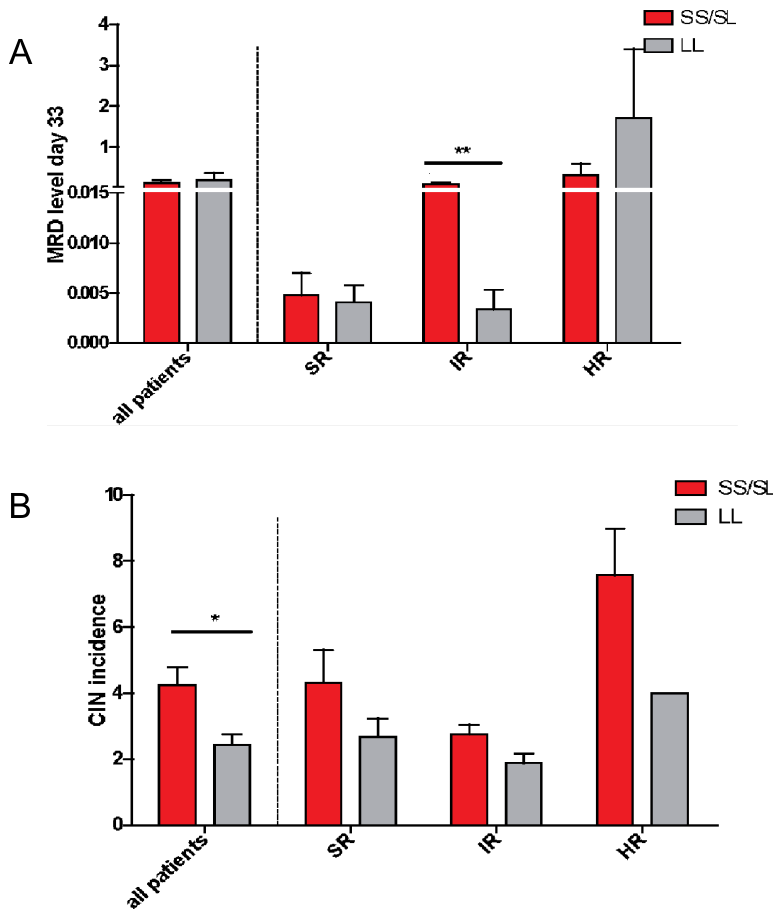
Figure 5. ( A ) MRD level at 33rd day of treatment in association with the presence of short alleles in patients, shown in all patients and separately in patients stratified into the particular risk groups. Mean MRD was 0.086 ± 0.17 in patients with at least one S allele versus mean MRD 0.0033 ± 0.006 in the LL patients. In the SR group—data available for 15 patients, in the IR group for 28 patients, in the HR group for 10 patients. ( B ) CIN incidences in association with the presence of short alleles in patients, shown in all patients, and separately in patients stratified into the particular risk groups. Then the influence of genotype and a risk group was calculated as independent variables on a number of CIN incidents. It appeared that the main effect resulted from the risk group (two-way ANOVA, p = 0.0005), but there was also an effect of genotype ( p = 0.0055). In the SR group—data available for 15 patients, in the IR group for 24 patients, in the HR group for 10 patients. Data are presented as means and SEM * p < 0.05, ** p < 0.01.